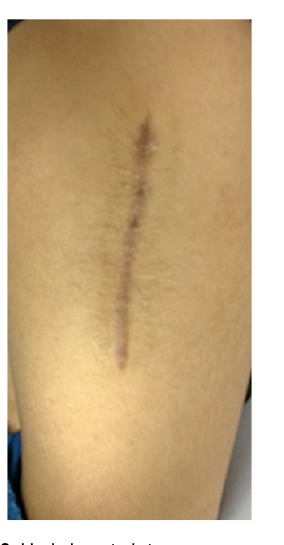
Figure 8. Healed surgical site